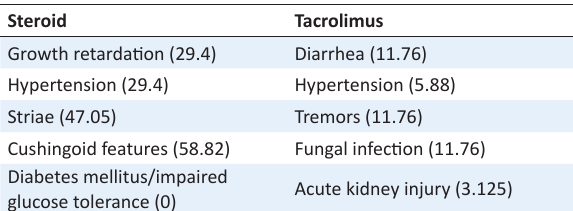
Table 2. Adverse effects of steroid therapy at the time of enrollment and those related to Tac therapy (parenthesis